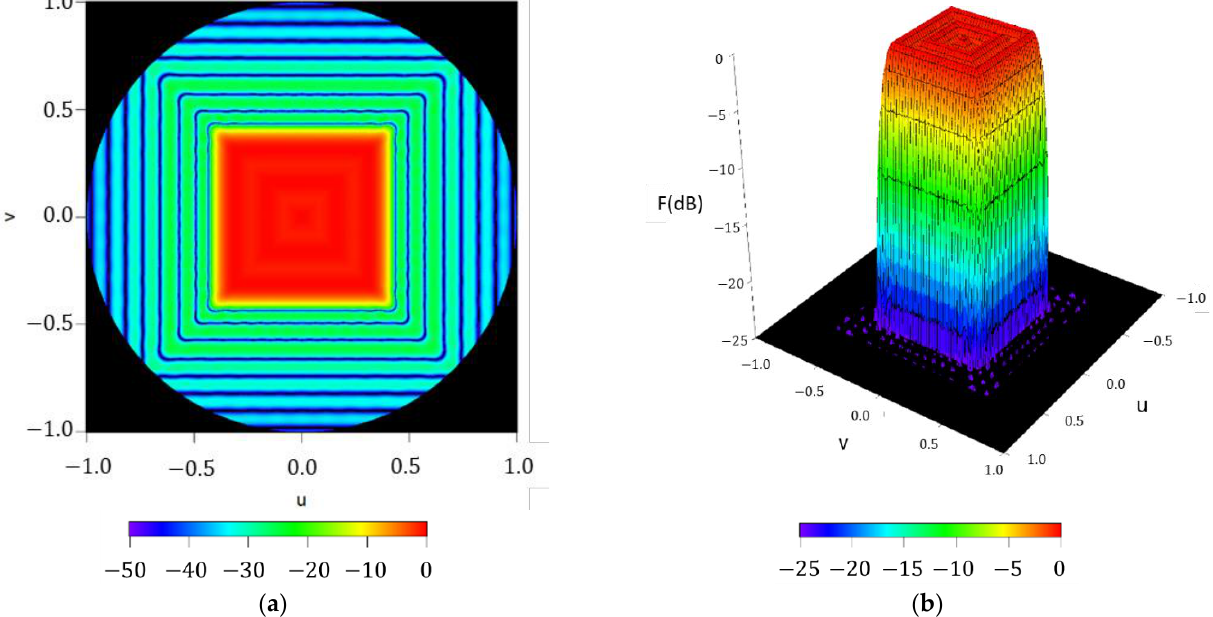
Figure 4. Reconstructed pattern of the test case of a square boundary of approximately 40 ◦ × 40 ◦ by means of the obtained Fourier coefficients in (2): ( a ) interpolated image with a threshold level set at − 50 dB; ( b ) surface plot with a threshold level set at − 25